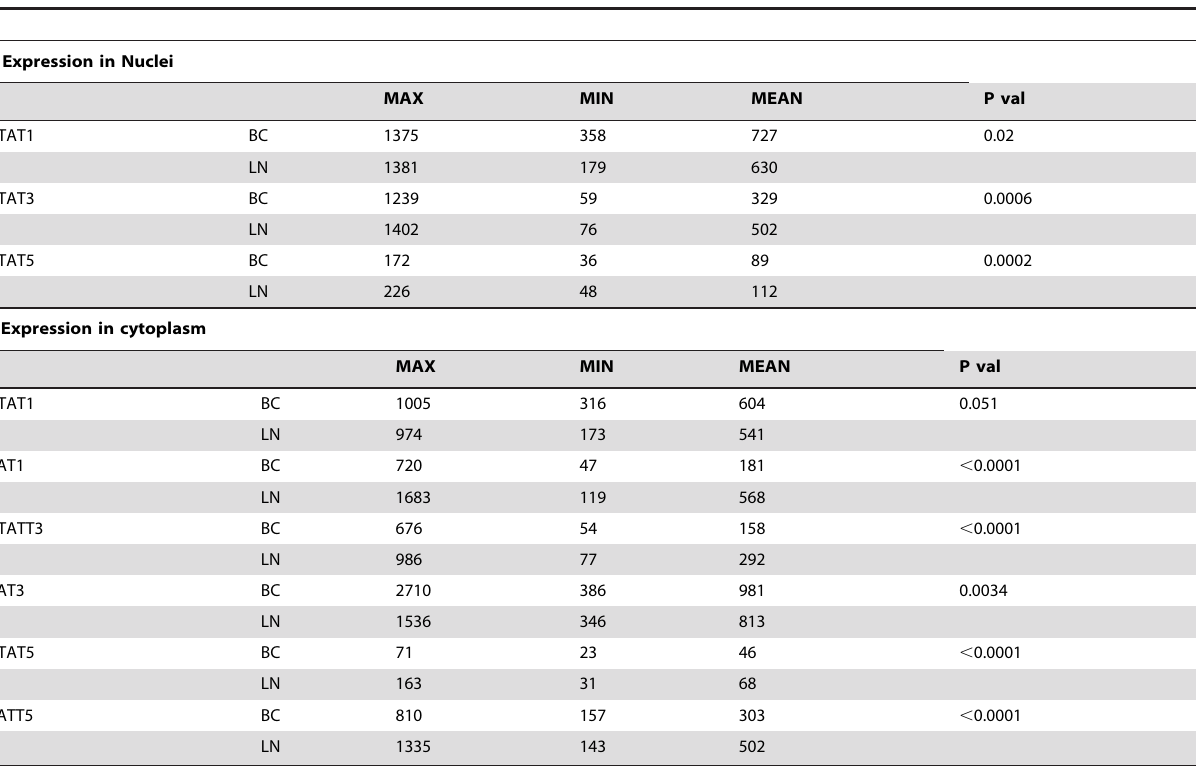
Table 2. Comparison of STAT and phospho-STAT expression between primary breast tumors (BC) and matched lymph node (LN)